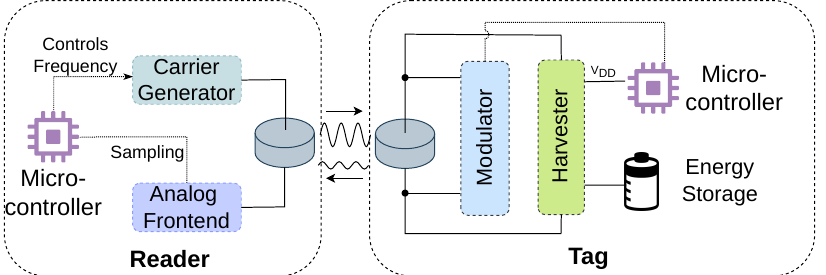
Figure 2. The general architecture of the hardware prototype. The backscatter modulator and the energy harvester work on the same piezoelectric transducer.